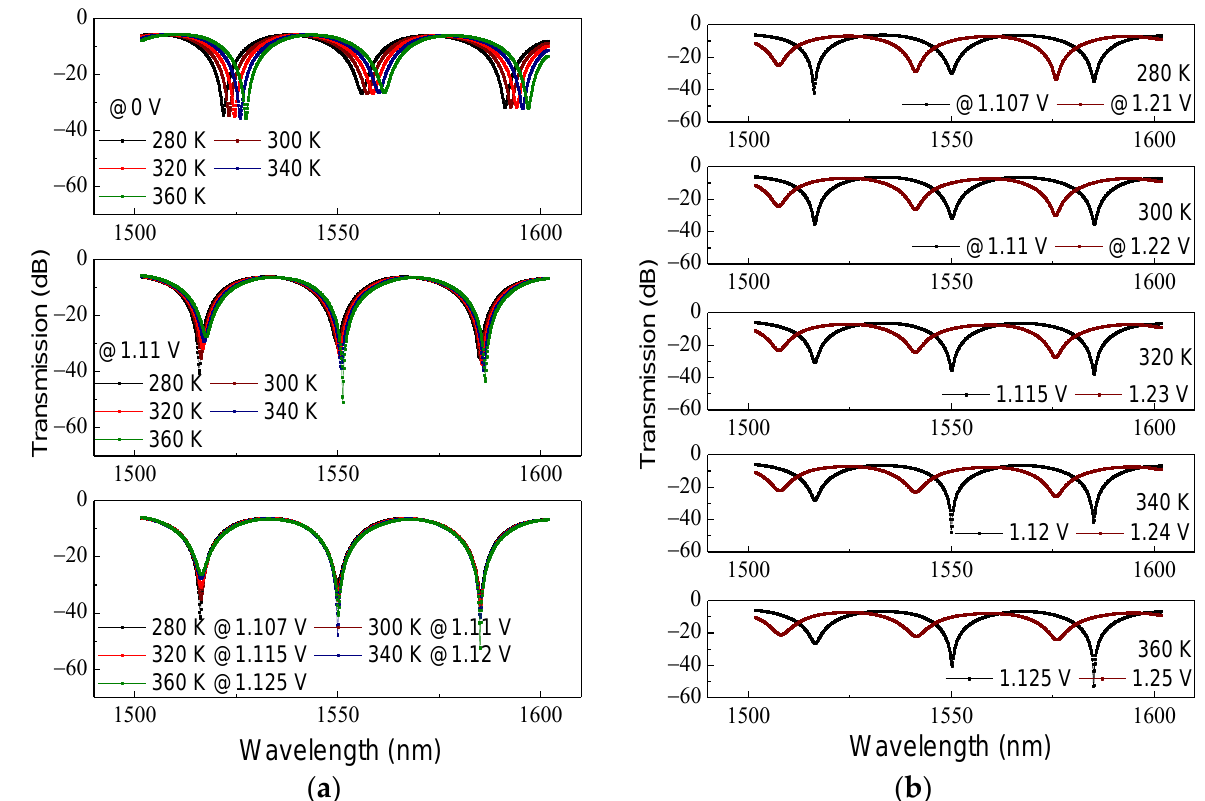
Figure 4. ( a ) The method of resonance tuning by injected carrier concentration; ( b ) the transmission curve of “on-state” and “off-state” for different temperatures.